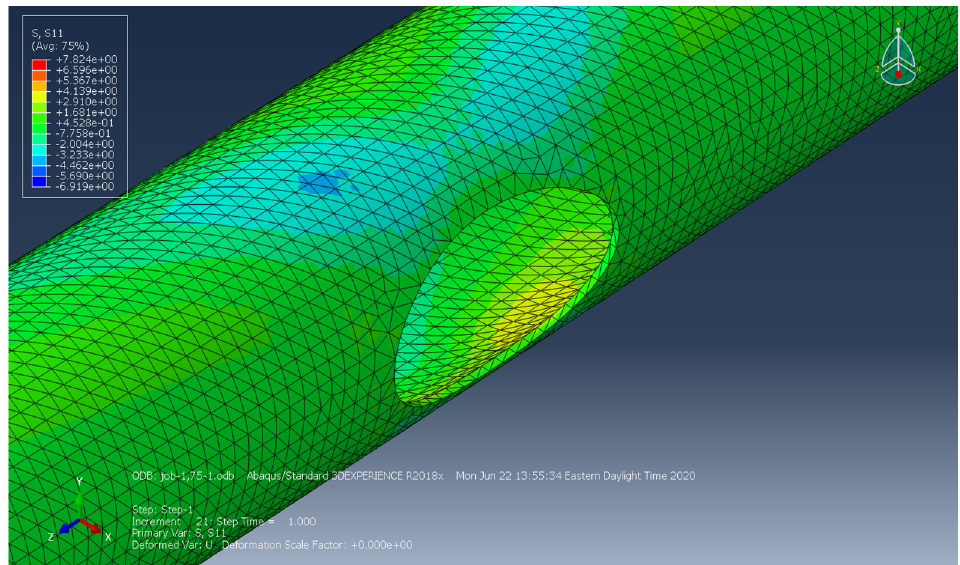
Figure 18. Aspect ratio 1.5-1 in transverse (X) direction.